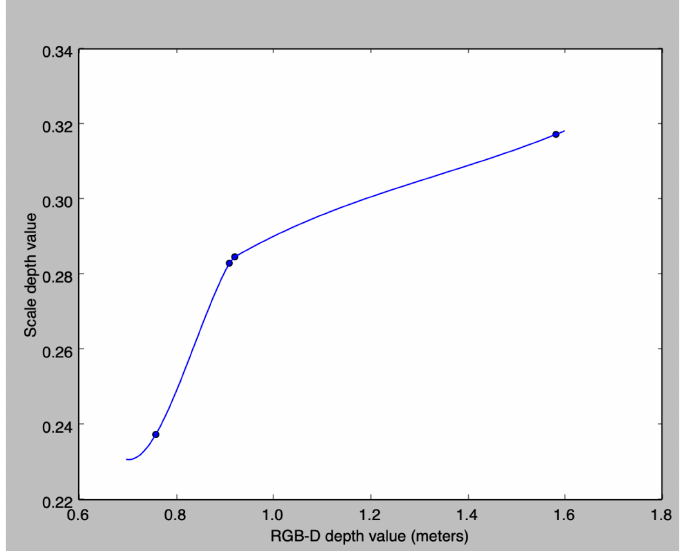
Figure 10. In the figure, the depth values provided by the QUEsT method [41] are fitted with a spline regression. The fitted line shows a non-uniform displacement of the RGB-D depth values [49].